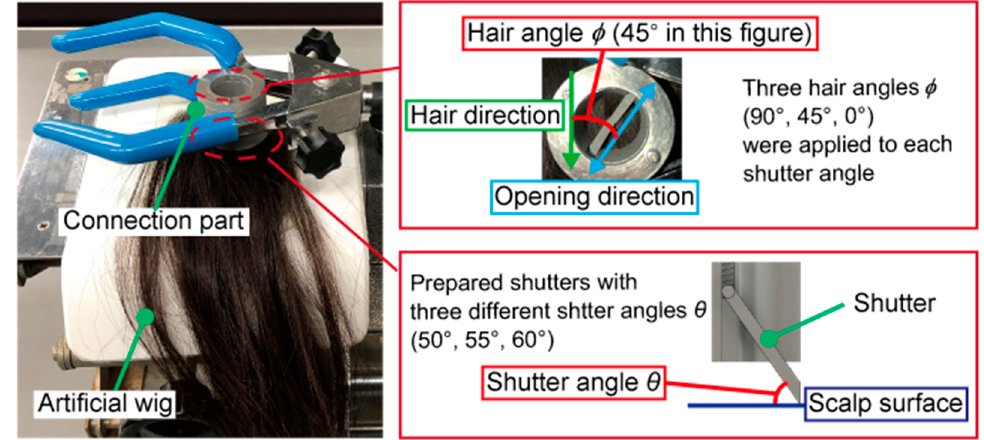
Figure 7. Photograph of the shutter angle test and definitions of the angles θ and φ . The amount of hair near the shutter was randomly changed by hand each time.